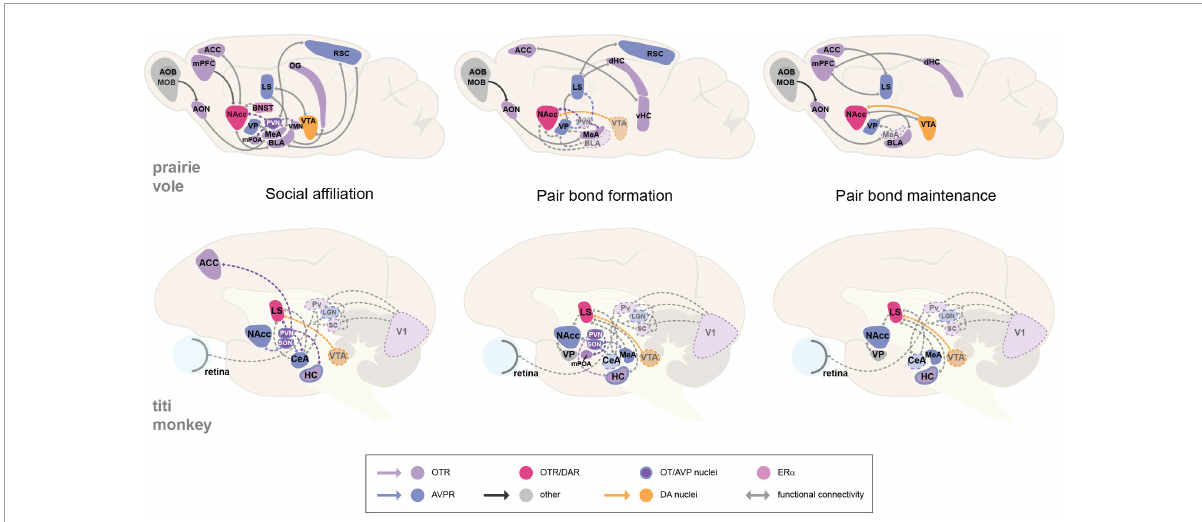
FIGURE1 Proposed neural circuits of monogamous behavior in the prairie vole and the titi monkey. Illustrations show sagittal views of the prairie vole and titi monkey brain that propose neural circuit models for social affiliation, pair bond formation, and pair bond maintenance. The behaviors imply the recruitment of reward-modulating areas with social-salience processing regions, producing an association between a social cue or stimuli with a reward encoding and response. The activation of particular brain areas may be context-dependent, hence the dashed connecting lines and dashed brain region outlines that show hypothesized interactions that are likely involved, but have yet to be demonstrated for these circuits. OT, oxytocin; AVP, arginine-vasopressin; DA, dopamine; ER α , estrogen receptor alpha; OTR, oxytocin receptor; AVPR, arginine vasopressin receptor; ACC, anterior cingulate cortex; AOB, accessory olfactory bulb; AON, anterior olfactory nucleus; BLA, basolateral amygdala; BNST, bed nucleus of the stria terminalis. CeA, central amygdala. DG, dentate gyrus. HC, hippocampus. dHC, dorsal hippocampus. MeA, medial amygdala. MOB, main olfactory bulb. LGN, lateral geniculate nucleus. LS, lateral septum. mPFC, medial prefrontal cortex. mPOA, medial preoptic area. NAcc, nucleus accumbens. Pv, pulvinar. PVN, paraventricular nucleus of the hypothalamus. RSC, retrosplenial cortex. SC, superior colliculus. SON, supraoptic nucleus. VP, ventral pallidum. vHC, ventral hippocampus. VTA, ventral tegmental area. V1, primary visual